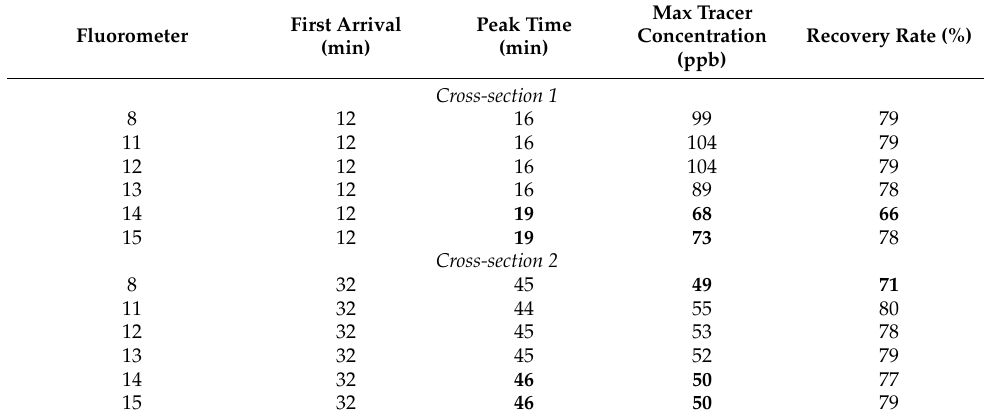
Table 2. First arrival, peak time, peak tracer concentration, and recovery rate for each fluorometer of cross-sections 1 and 2. Outliers or discussed values are in